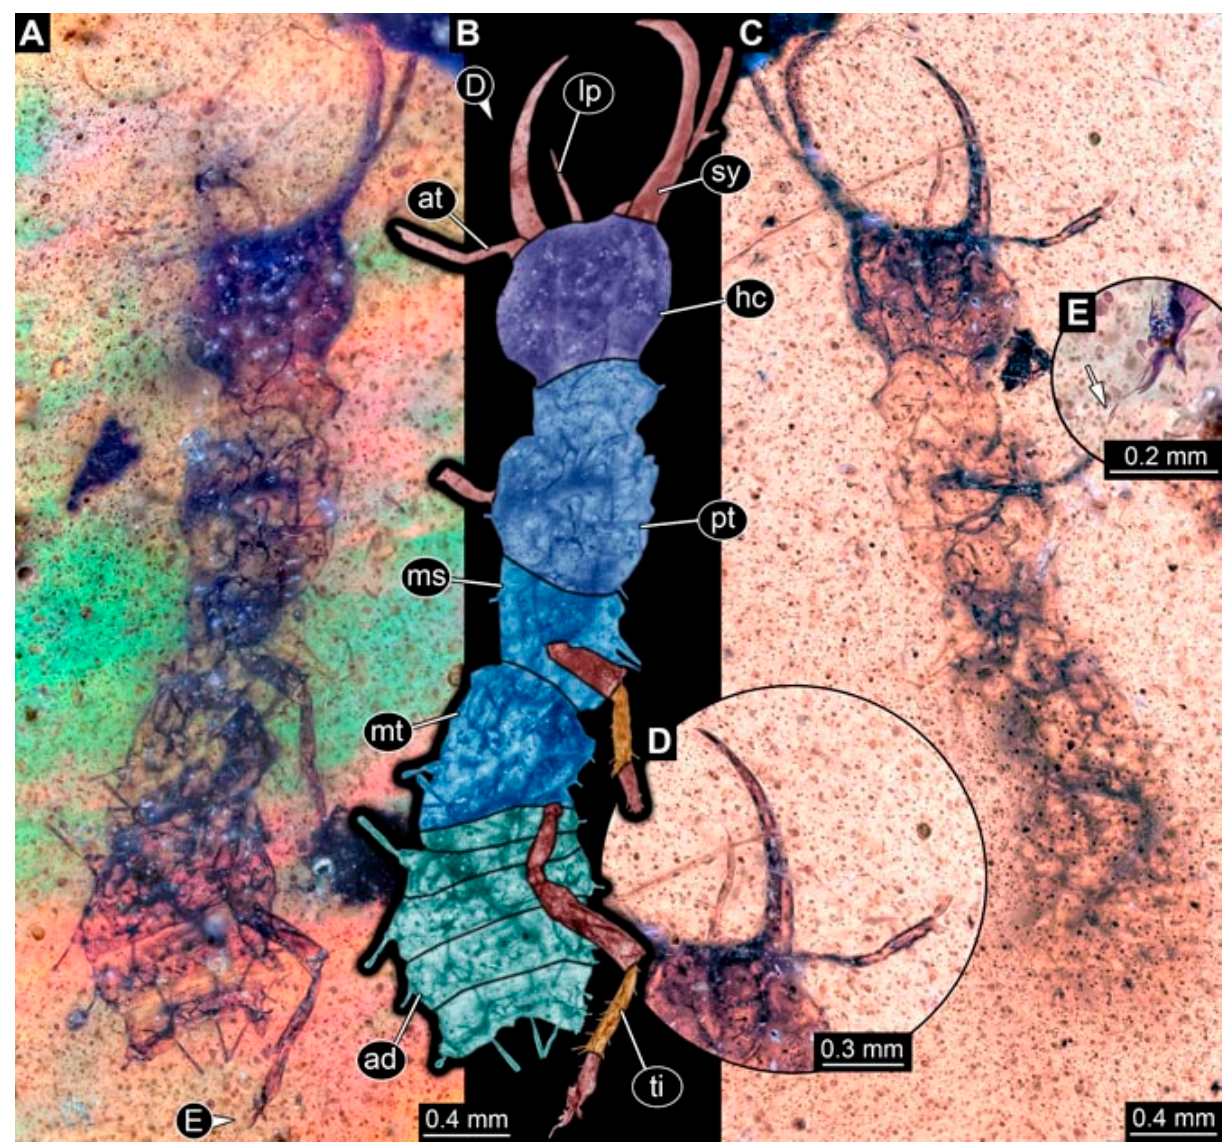
Figure 21. Specimen 4842 (PED 0441); Myanmar amber. ( A ) Ventral view. ( B ) Ventral view, colour- marked. ( C ) Dorsal view. ( D ) Close-up of stylet in dorsal view. ( E ) Close-up of distal end of trunk appendage with empodium (arrow). Abbreviations: ad = abdomen; at = antenna; hc = head